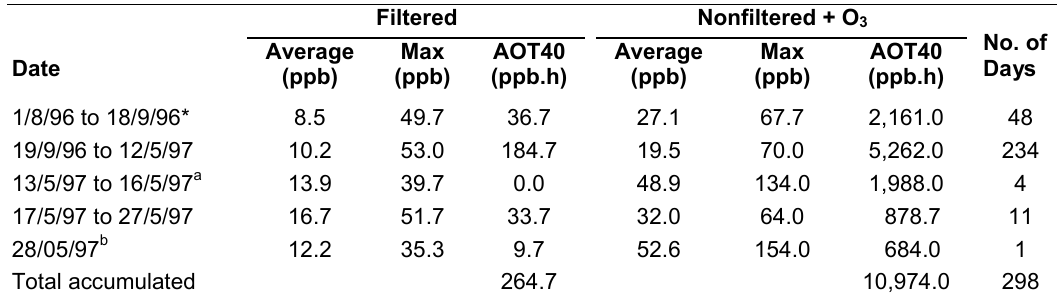
Average Hourly Maximum Ozone Concentration (ppb) and AOT40 Index (ppb.h) during the Different OTC Exposition Steps for Each Treatment and the AOT40 Accumulated at the End of the Experiment for Each Treatment (n = 3)